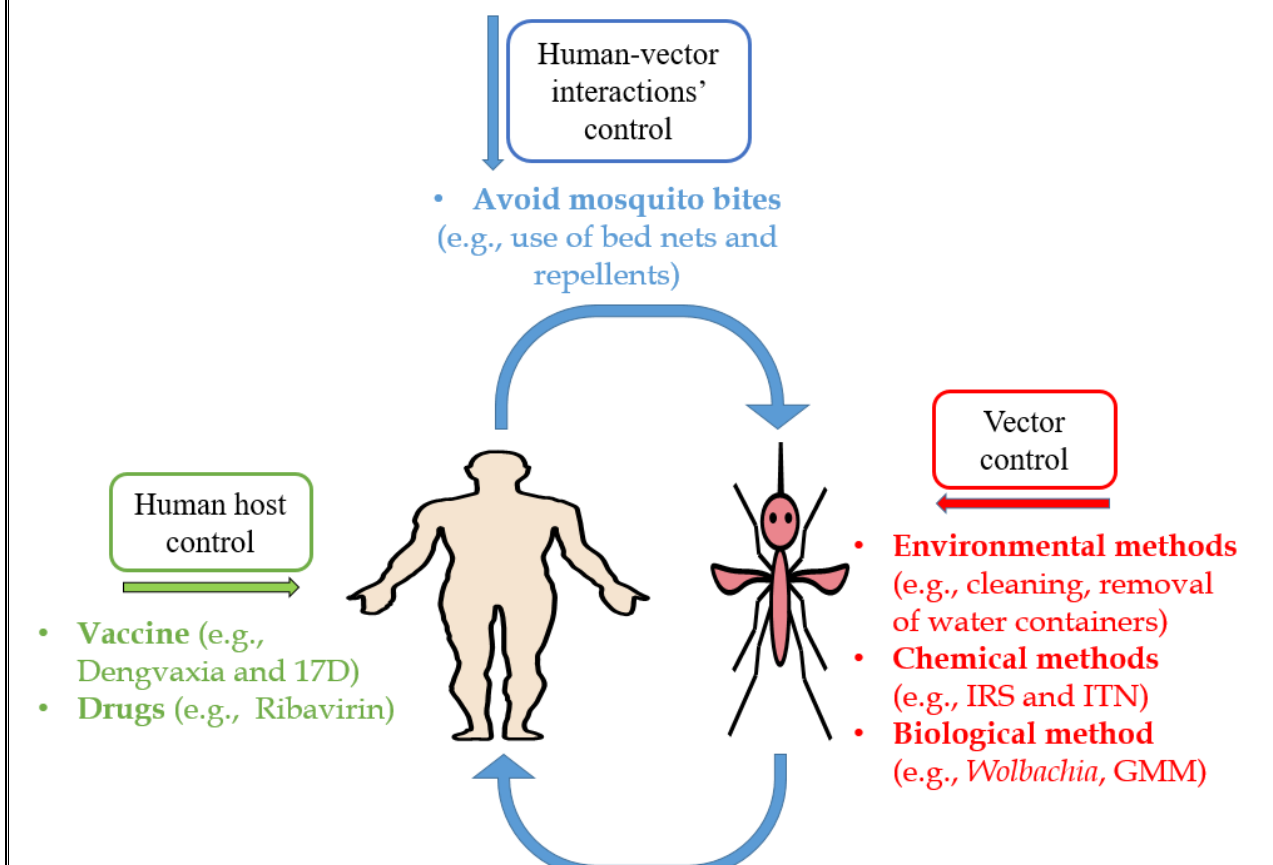
Figure 2. Diagram showing the summary of methods and examples (in brackets) that could be used to control Aedes -borne arboviral transmission: The green text refers to the human-host strategies, which could be used to prevent arboviral transmission via vaccines and drugs. The blue text refers to the human-vector interactions’ strategies that could be used for arboviral transmission control via humans avoiding bites from infectious mosquitoes. The red text refers to the vector control strategies that include chemical, environmental or biological methods to control arboviral transmission (IRS — indoor residual spraying; ITN — insecticide-treated bed nets; GMM — genetically modified mosquitoes).